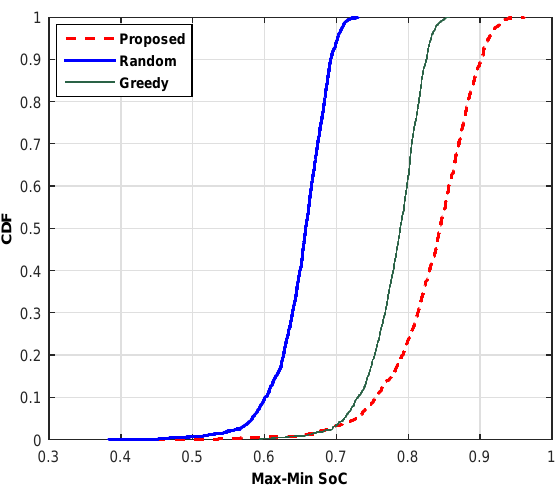
Figure 9. Cumulative distribution function of